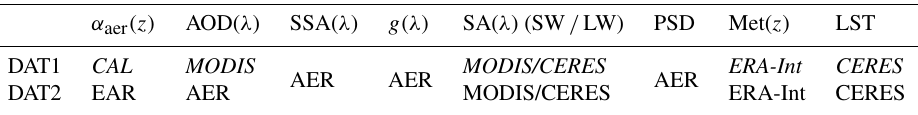
Table 2. Input parameters used for GAME retrievals of the DRE for parameterizations 1 (DAT1) and 2 (DAT2). Those parameters which are variable along the track are marked using italic font (CAL refers to CALIPSO; AER refers to AERONET; EAR refers to EARLINET; ERA-Int refers to